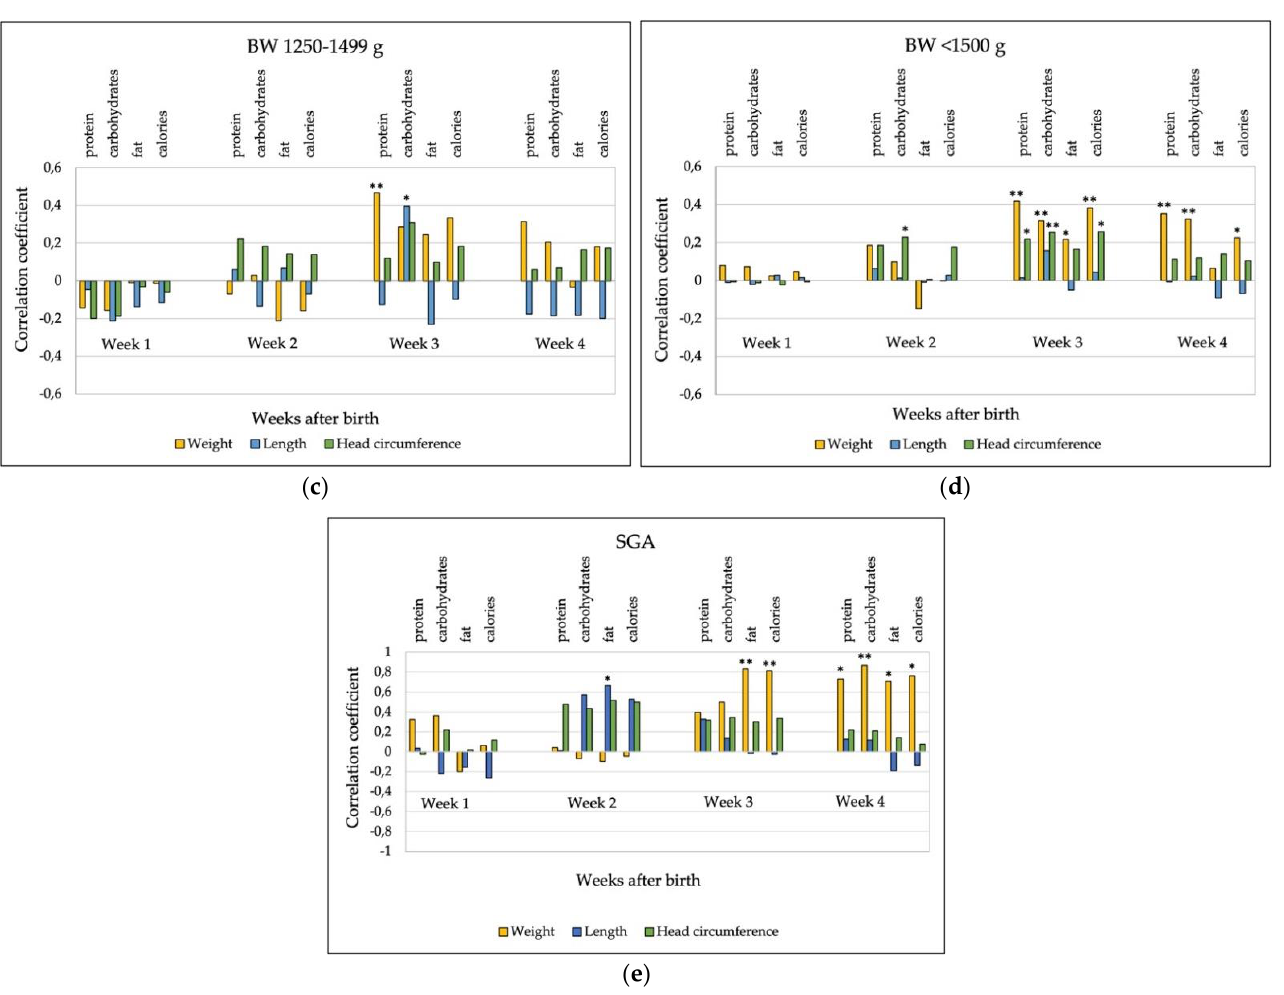
Figure 5. Correlations (Spearman’s rho) between nutrient and energy intake and growth during the first 4 weeks. ( a ) Birthweight group <1000 g; ( b ) birthweight group 1000 – 1249 g; ( c ) birth weight group 1250 – 1499 g; ( d ) the whole cohort, ( e ) SGA infants. * Correlation is significant at 0.05 level; ** correlation is significant at 0.01 level.